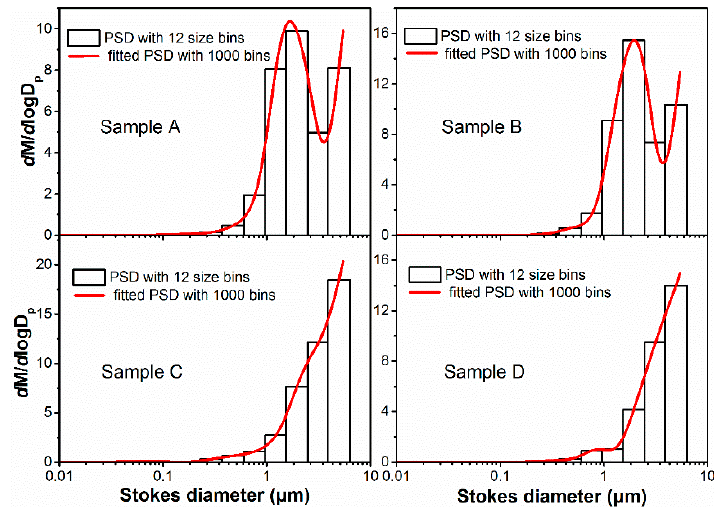
Figure 10. The particle size distributions (PSDs) of the four aerosol samples (A–D). (The histograms represent the measurements of the instruments with 12 size bins, and the curves represent the interpolating fitting with 1000 size bins).